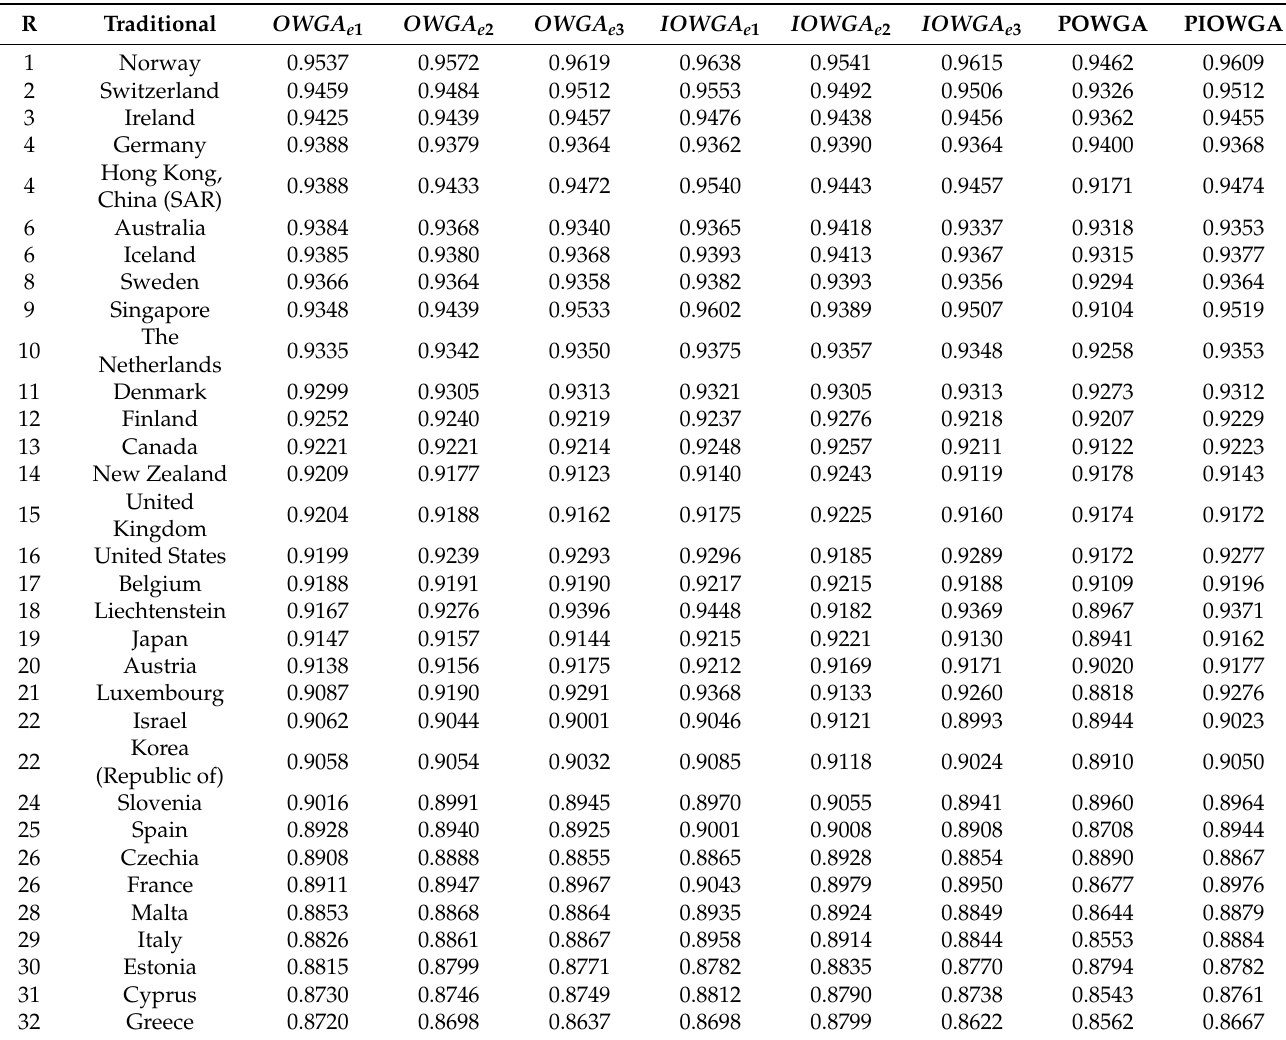
Table A1. Results of the HDI index using different aggregation